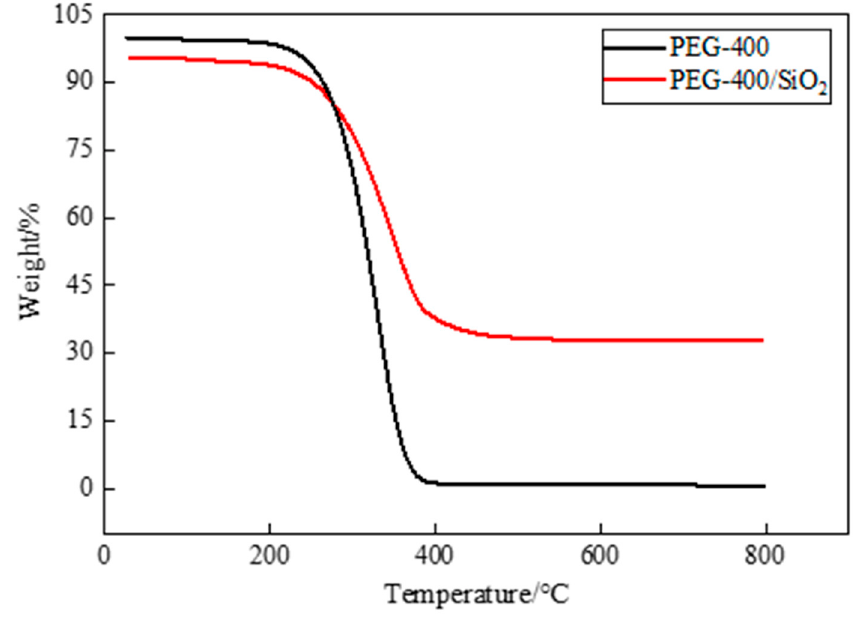
Figure 7. TGA curves of PEG-400 and PEG-400/ SiO 2 composite shaped PCM.